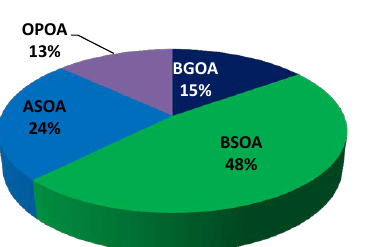
Figure 9. Daily levoglucosan values observed during the PAR- TICULES project from September 2009 to September 2010 at the downtown urban and southern rural sites. The rural site is located far from direct sources. Levoglucosan is a tracer for wood-burning emissions. The similar values at both sites ( R 2 = 0 . 83, slope rural vs. downtown site 0.84) suggest a strong regional control of wood- burning-related organic